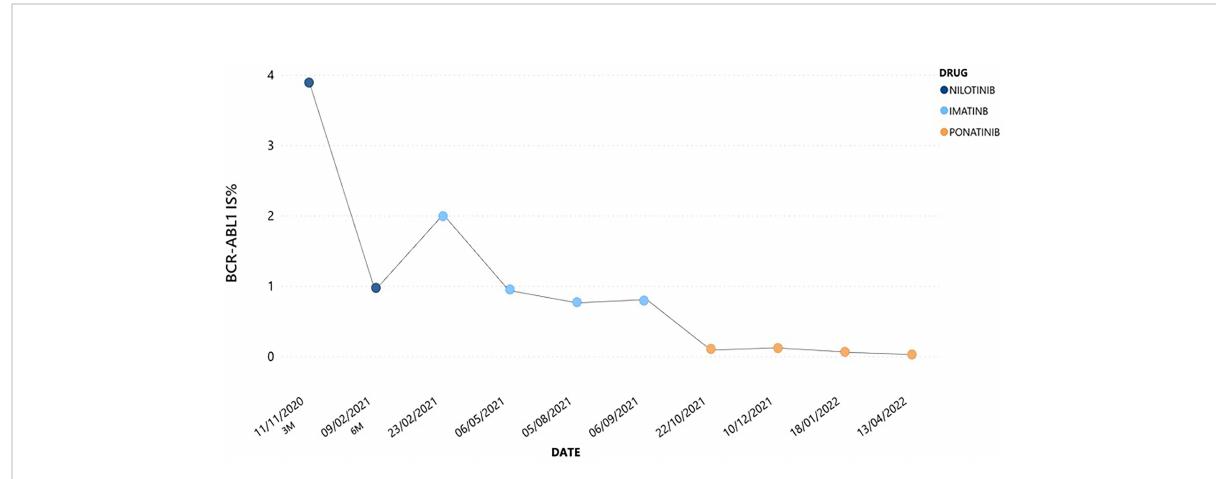
FIGURE 1 BCR::ABL1 transcript levels during the treatment with each